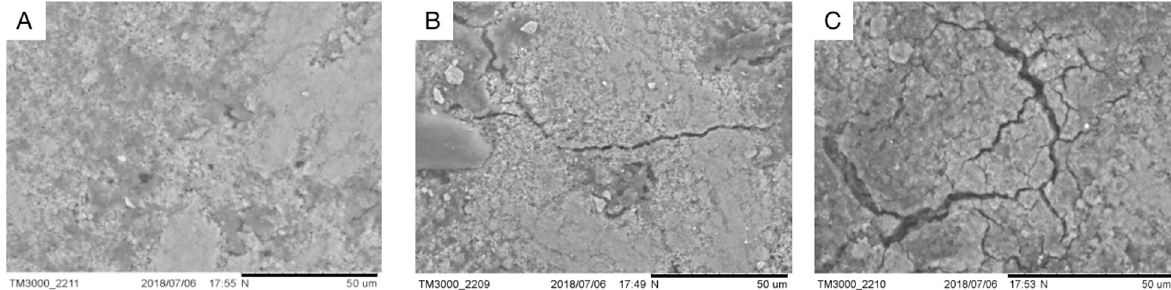
8 of 14 Table 2. Texture pro fi le analysis of egg yolk with salting time. Time